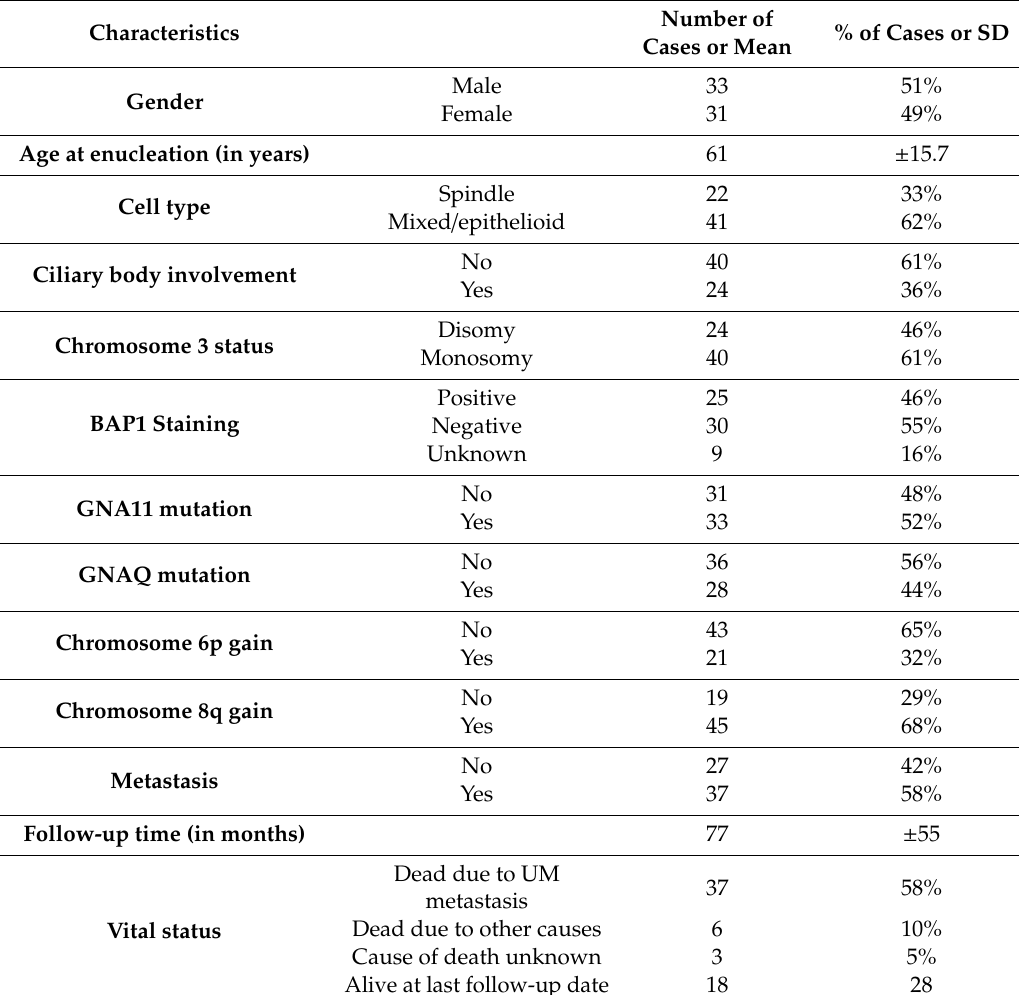
Table 6. Characteristics of the cohort of uveal melanoma (UM) patients enucleated in the LUMC between 1999 and 2008 ( n =